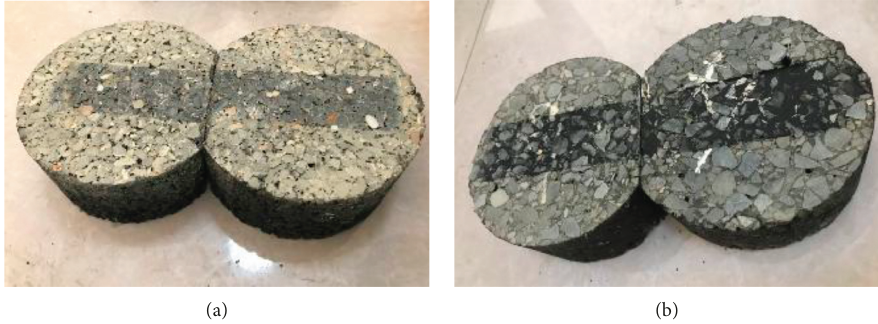
Figure 9: Specimens after the test. (a) PUM and (b) SMA.